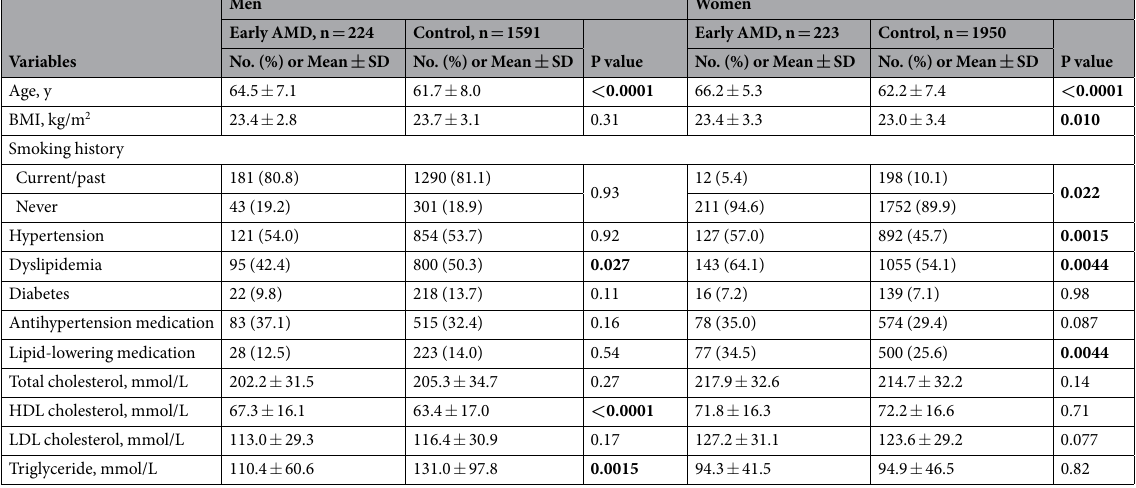
Table 2. Basic characteristics according to sex. Significant values are in